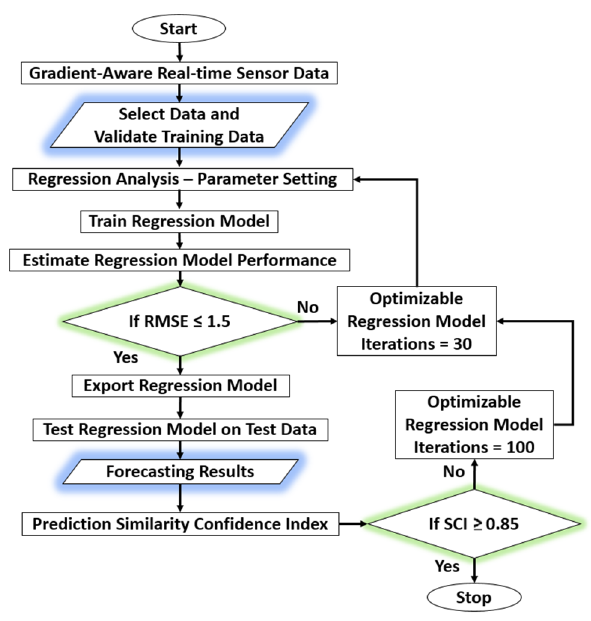
Figure 2. The Optimized Bi-Cluster Regression Algorithm.